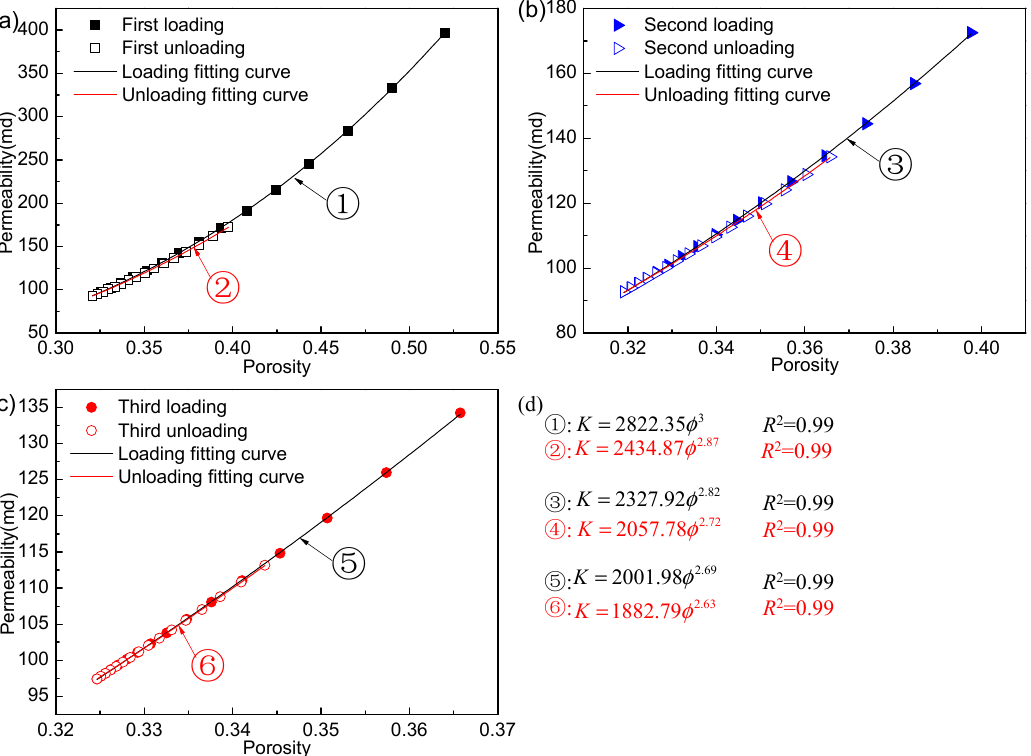
Figure 15. Relation curve between permeability and porosity under cyclic loading and unloading conditions of broken coal samples: ( a ) the first cyclic loading and unloading, ( b ) the second cyclic loading and unloading, ( c ) the third cyclic loading and unloading, ( d ) the fitting formulas between permeability and porosity.